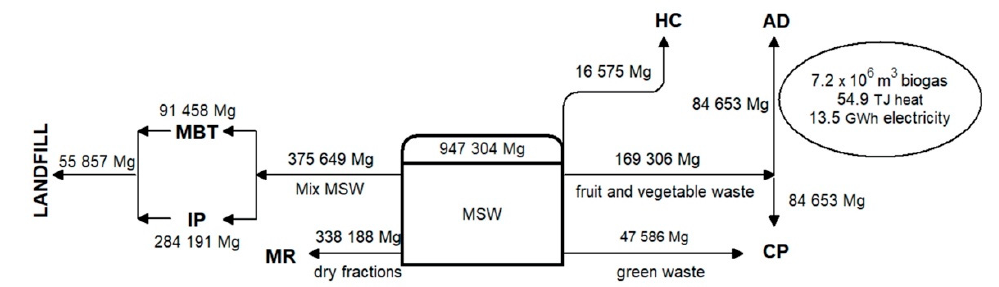
Figure 8. MFA for TS-II-S3, prediction for 2035.